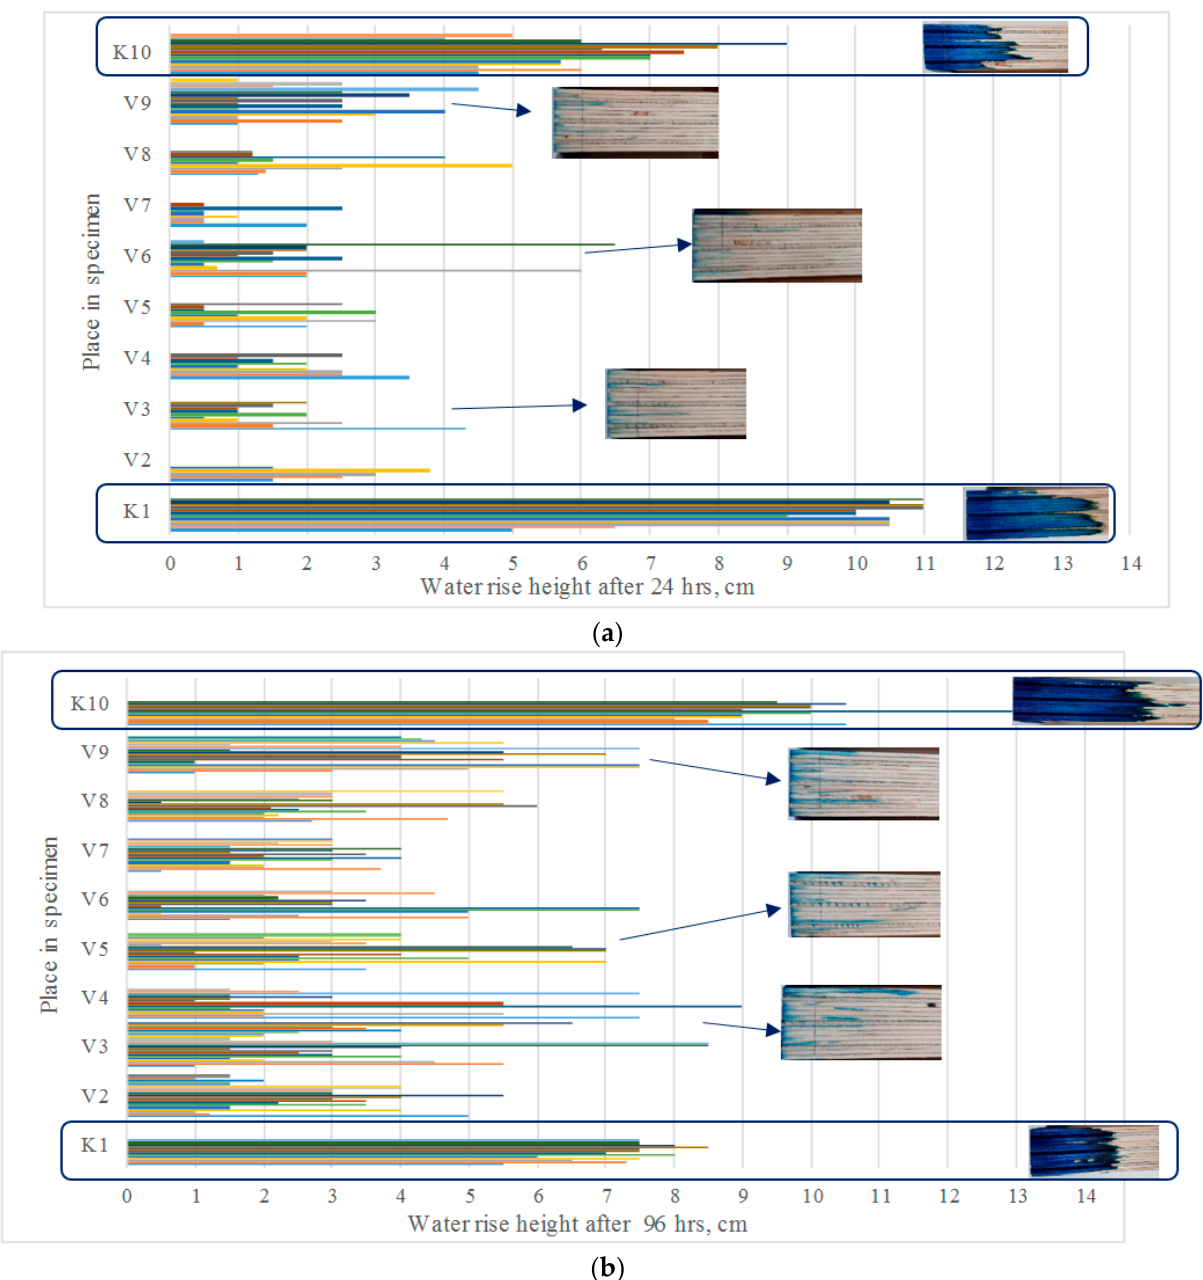
Figure 6. Height of the water rise in the specimen after: ( a ) twenty-four hours; and ( b ) ninety-six hours, where the location of the specimen is: K for the edge of the specimen, and V for the inside of the specimen; different colors of bars indicate the height of the water rise of each plie of the LVL panel.